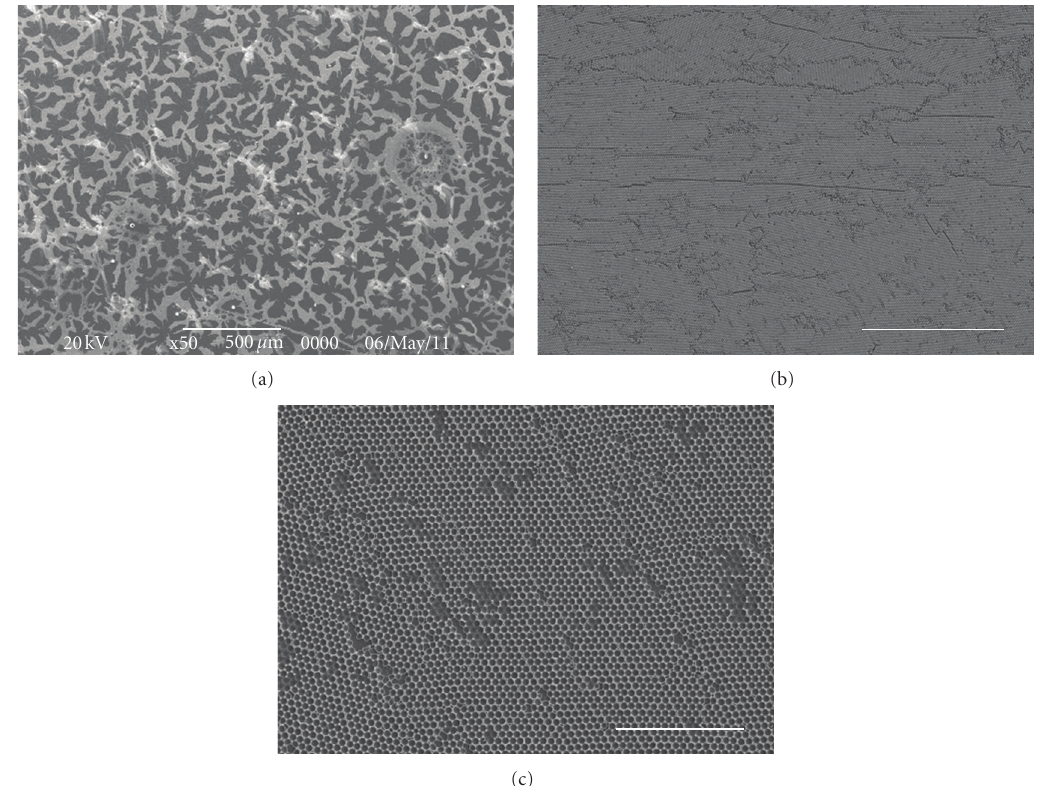
Figure 4: SEM images of typical sphere packing on a gold electrode using (a) the spin-coating method and (b) the vertical deposition method. (c) SEM of the nanowells formed in a film prepared via the vertical deposition method. (Scale bar: (a) 500 µ m, (b) 50 µ m, and (c) 10 µ